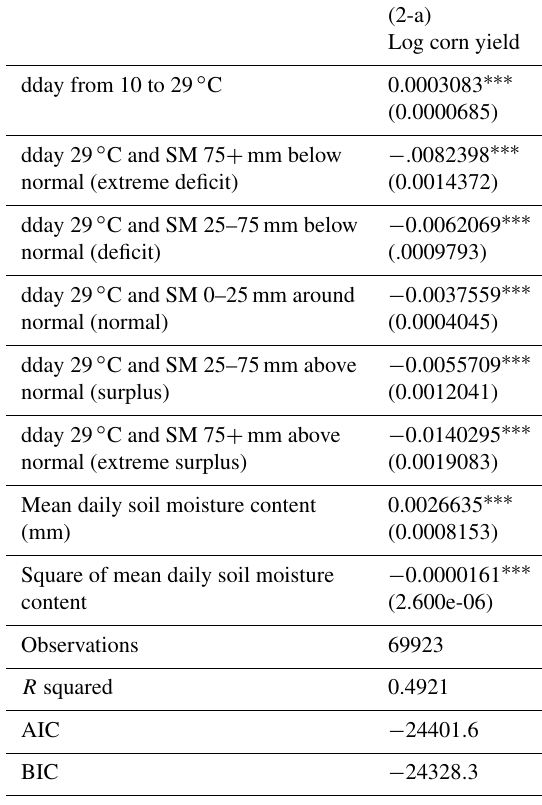
Table 3. Corn yield estimation while splitting the heat stress index in Model (2-a).